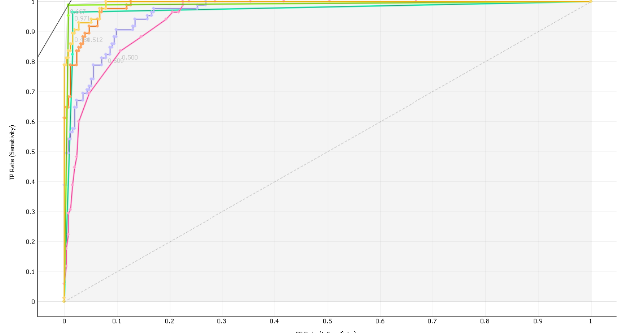
Fig. D3. ROC curve analysis relating to class